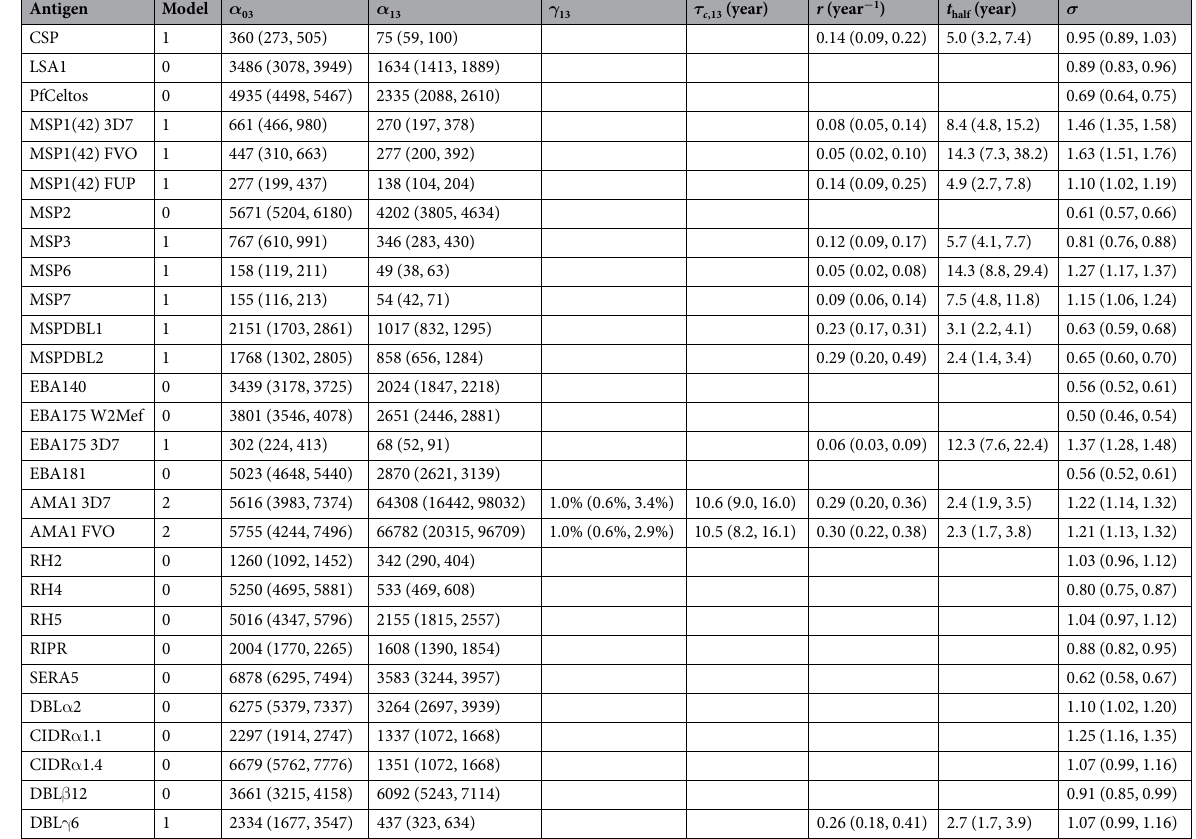
Table 2. Antibody acquisition model parameters. Results shown are the median and 95% credible intervals from the posterior parameter distribution estimated using Bayesian Markov Chain Monte Carlo (MCMC) methods. All parameters were assumed to have improper uniform priors. Of the three models tested, the best fit was selected using the Deviance Information Criterion (DIC). In the case where Model 0 was the best fit, α i is the geometric mean titre (GMT). In the cases where Models 1 or 2 are the best fit, α i is the antibody acquisition rate. r is the antibody decay rate, and t half is the antibody half-life – the time taken for antibody levels to reduce by 50% in the absence of exposure. τ c ,13 is the time of reduction of transmission in the 2013 cohort, where γ 13 is the ratio of transmission after the reduction compared to before